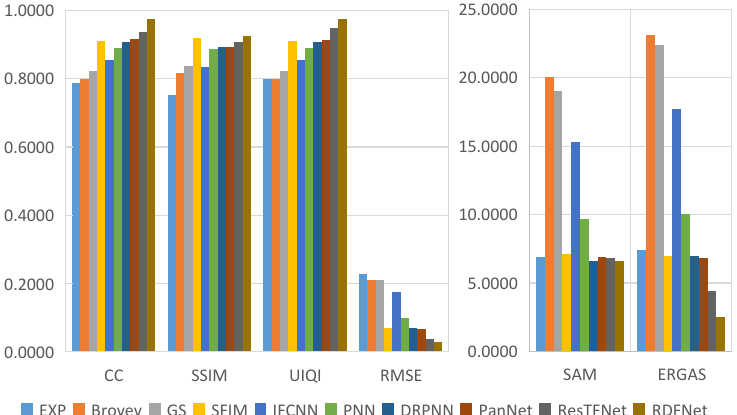
Figure 24. Quantitative metrics of testing dataset fusion results on QuickBird with reduced